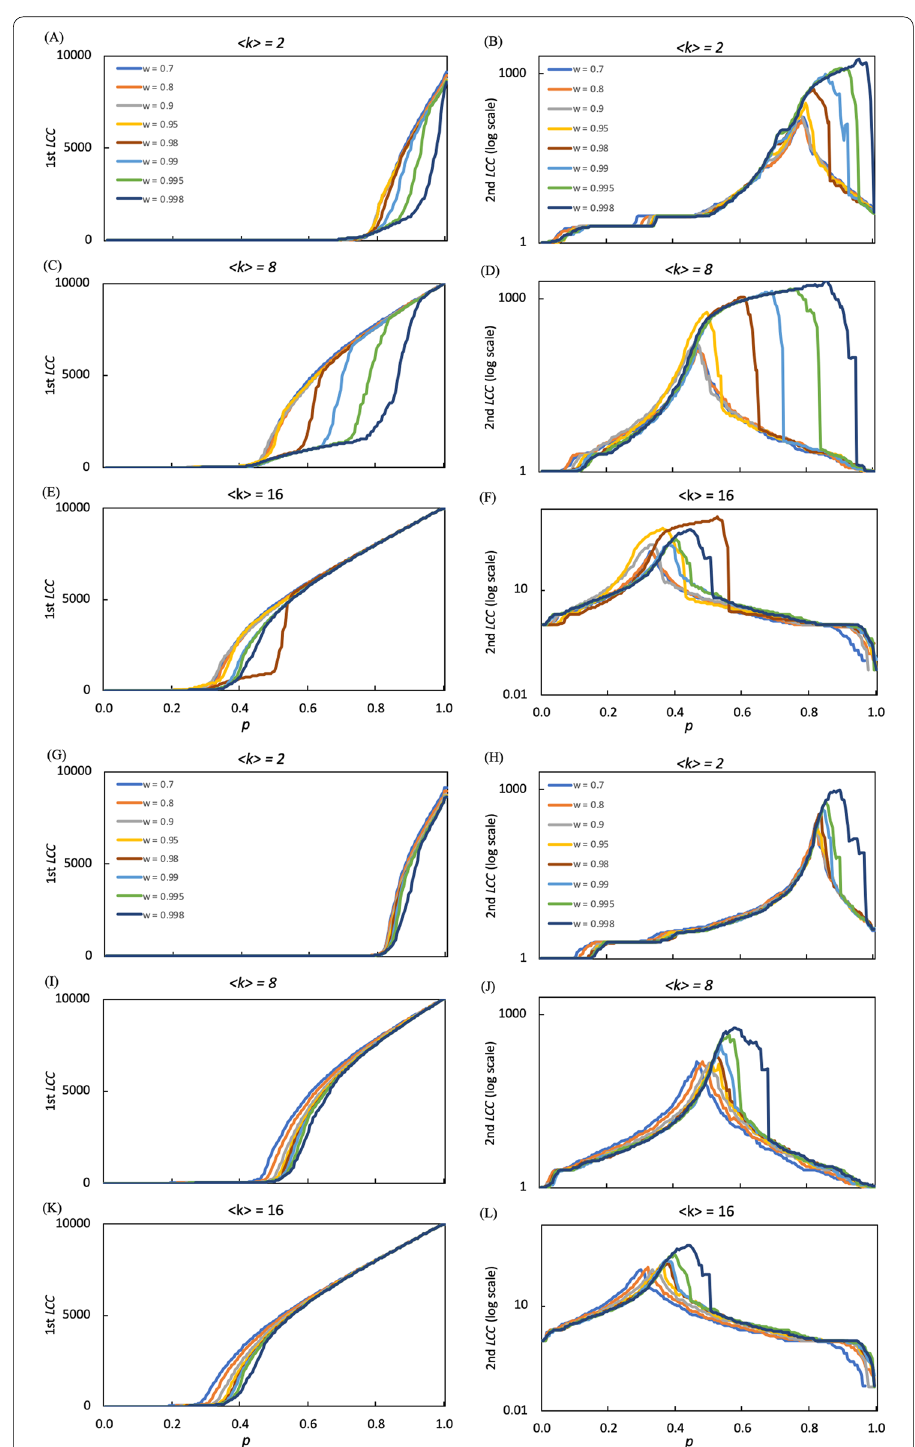
Fig. 6 Simulation result by IB and ID attack strategies for the modular networks generated from BA network with N 10,000, m 5 with different value of rewiring probability w and for different node average degree = = (cid:31) k (cid:30) . Size of the 1st LCC ( A , C , E ) and the 2nd LCC ( B , D , F ) as a function of the occupation probability p when attacked by IB for various average node degree (cid:31) k (cid:30) . Size of the 1st LCC ( G , I , K ) and the 2nd LCC ( H , J , L ) as a function of the occupation probability p when attacked by ID for various average node degree (cid:31) k (cid:30) . All results are averaged over 100